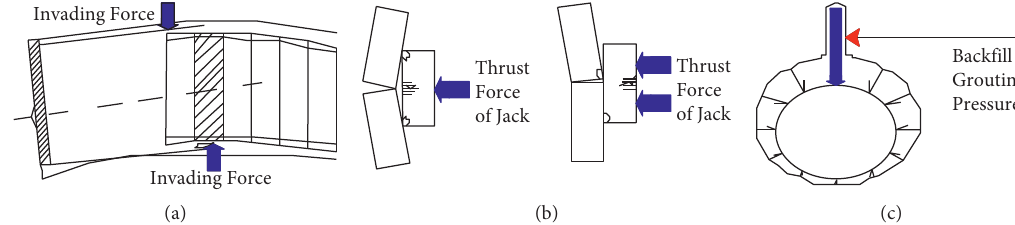
Figure 3: Typical cracking patterns in tunnel construction (reannotated based on reference [49]). (a) Invasion of shield tail. (b) Jack thrusting at deficient contacting segments. (c) Unsymmetrical